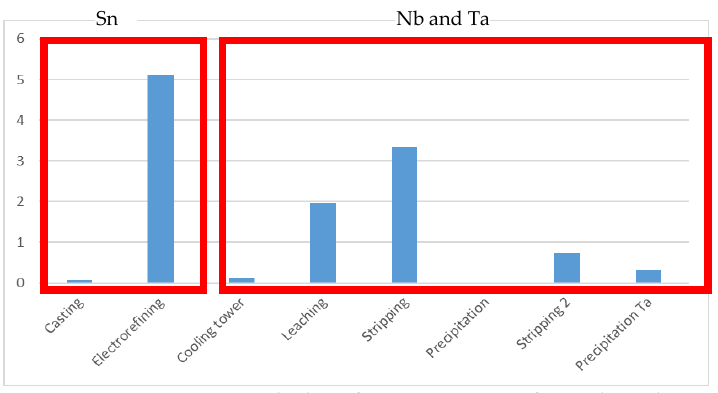
Figure 5. Water requirements in the beneficiation process of Sn, Nb, and Ta (in t/h).